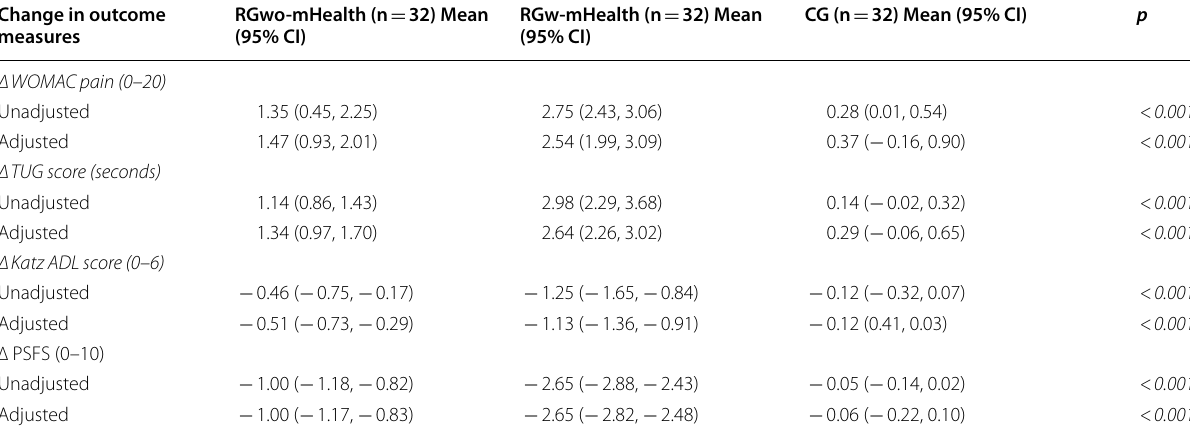
RGw-mHealth, rehabilitation group with mobile health; RGwo-mHealth, rehabilitation group without mobile health; CG, control group; WOMAC, Western Ontario and McMaster Universities Osteoarthritis Index; SD, standard deviation; TUG, timed up and go; ADL, activities of daily living; PSFS, patient specific functional scale; CI, confidence interval; n, number